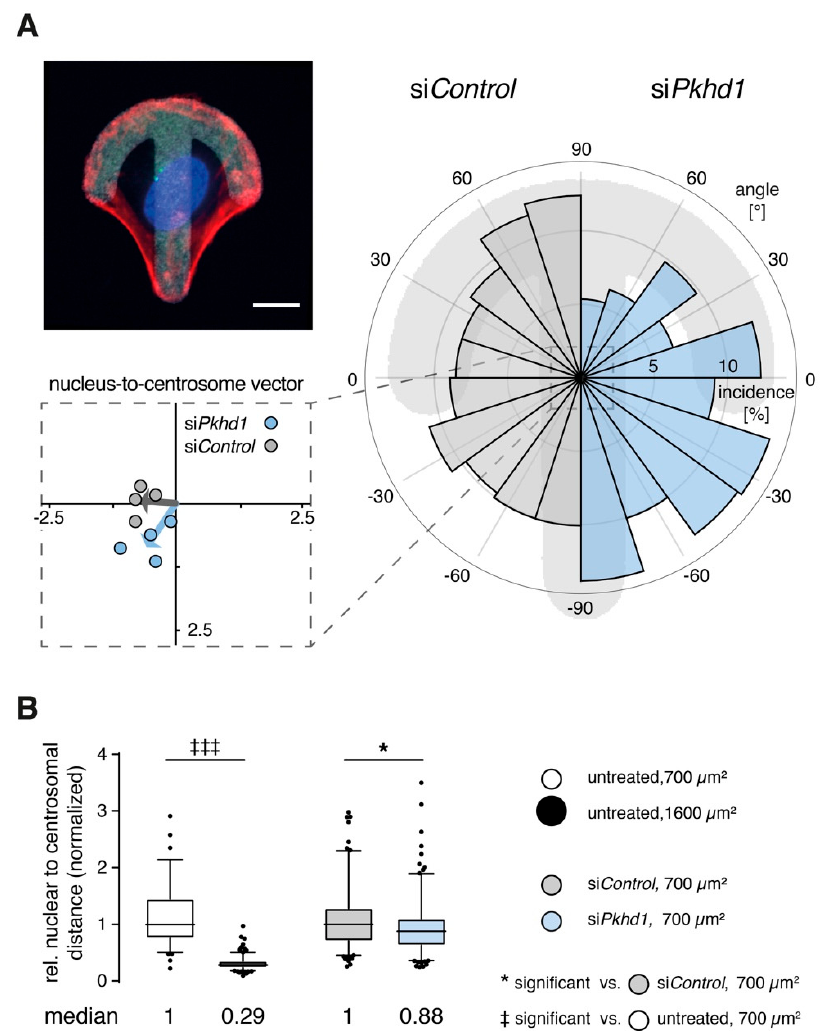
Figure 3. Defective positioning of centrosomes in 1 and 2-cell stages . ( A ) Adhesion of single cells on crossbow-shaped micropatterns (upper left) enforces positioning of centrosomes, in front of nucleus, corresponding to the polarized orientation of a migratory cell [22] (F-actin (red), nucleus (blue), centrosomes (green), pattern (white)). For si Control and si Pkhd1 -treated cells (right), angle distributions of nucleus-to-centrosome vectors are shown to mirror symmetrically ( − 90° to 90°). Mean vectors of independent experiments (lower left), as calculated from the total range ( − 180° to 180°), and total mean vector reveal a defect of si Pkhd1 cells in their ability to correctly place centrosomes towards the migratory front. ( n =250–310 cells, n = 4 independent experiments; p = 0.0026; non-parametric test for circular data corresponding to 1-way ANOVA [23]). Size bar, 10 µm. ( B ) In the 2-cell stage, central positioning of centrosomes is critical to initiation of lumen formation and is suppressed by strong peripheral contractility [13]. Using 2-cell stages, relation of relative nuclear to centrosomal distances was determined in untreated cells, on 700 and 1600 µm 2 , and in si Pkhd1 and si Control -treated cells on 700 µm 2 . Graphical illustration is provided in Supplementary Figure S4D. ( n = 2/5 independent experiments, >130/180 cell pairs per condition for untreated and siRNA-treated cells, respectively; non-parametric t -test/Mann–Whitney, p < 0.001/0.05, ‡‡‡/*). Initiation of lumen in epithelial spheroids is accompanied by positioning of centrosomes relative to nuclei, which is also an indicator of force distribution between adjacent cells pairs [24]. In high cell